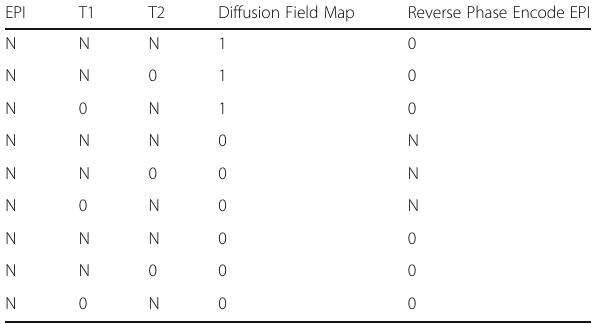
Table 3 (abstract A8). Nine pipelines to be